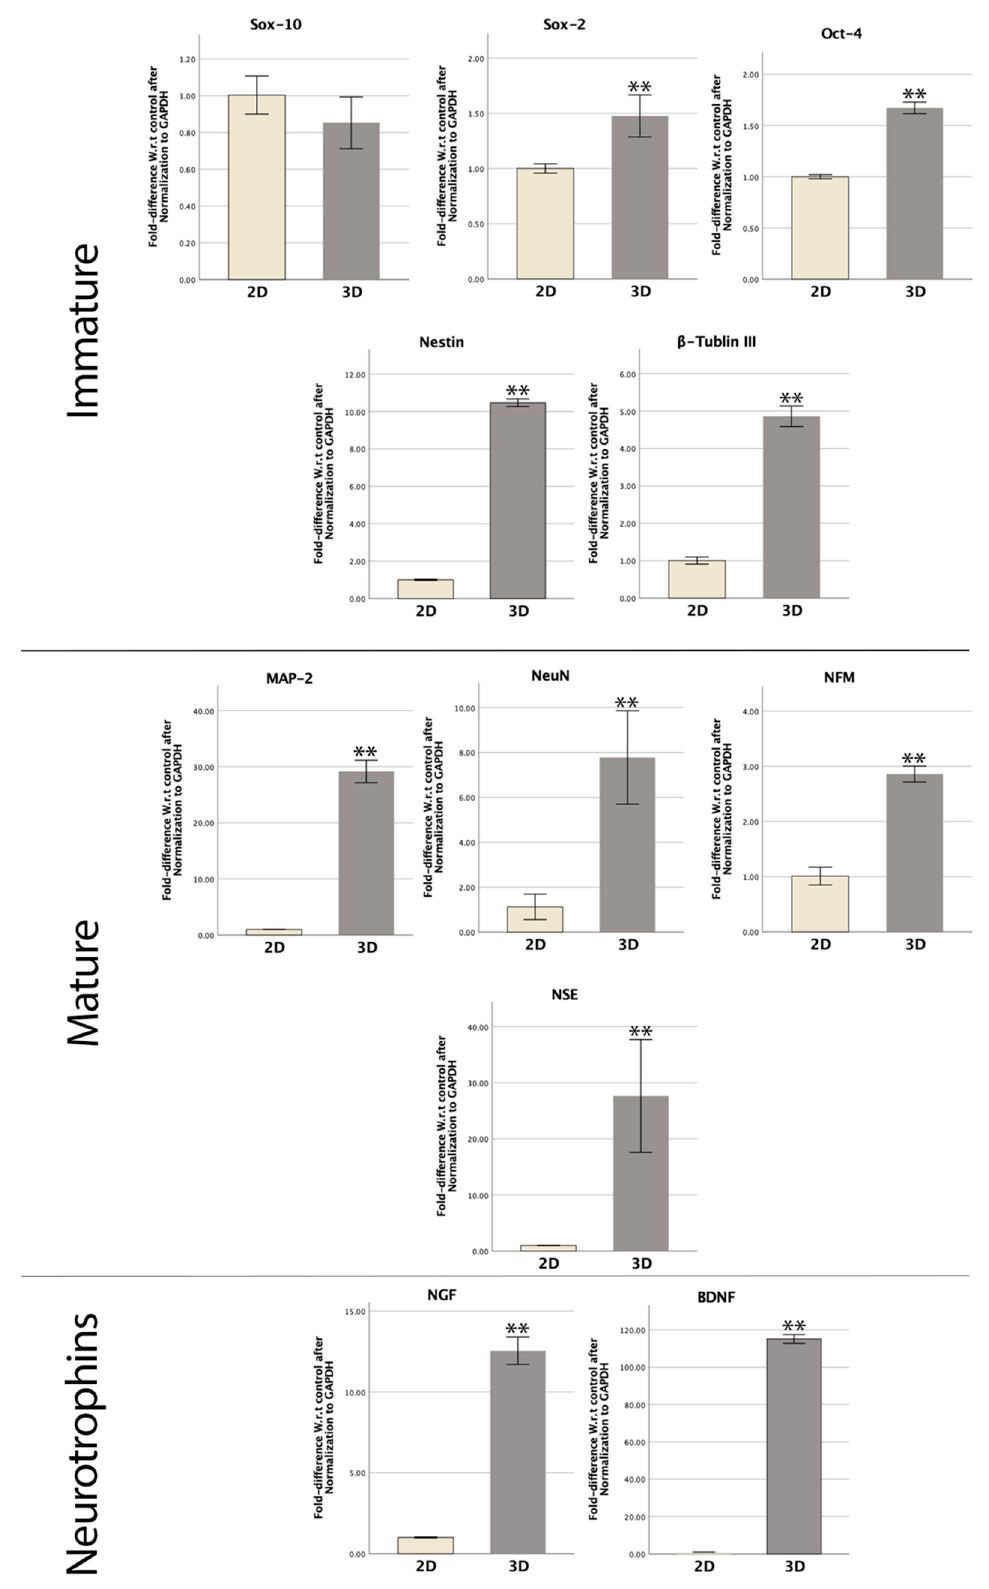
Figure 6. RT-qPCR for control SCAPs and 3D-cultured SCAPs at day 7 for the fold difference with reference to control after normalization to GAPDH of multiple neural markers (Student’s t -test, **: p < 0.01).